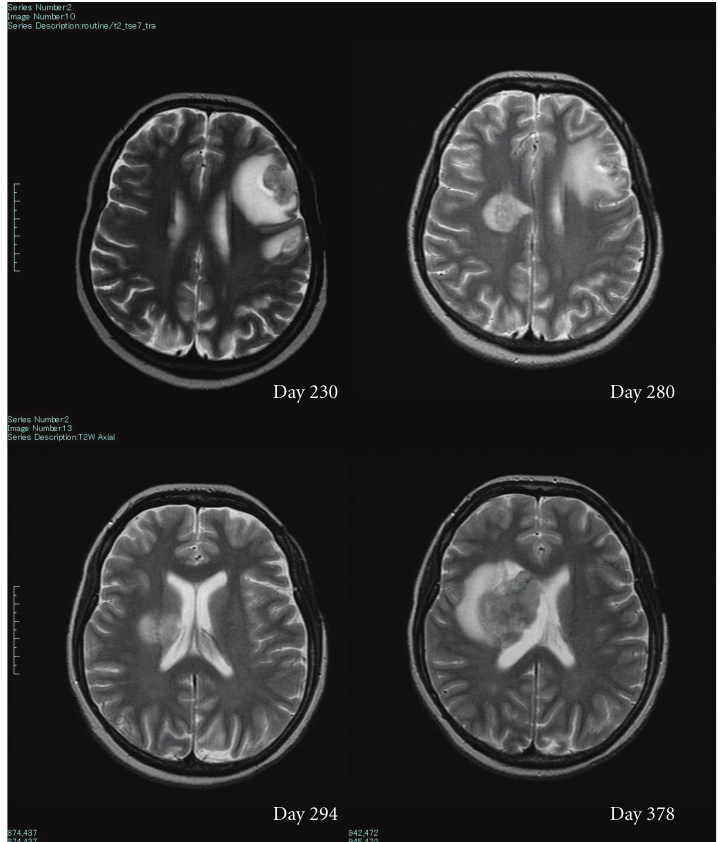
Figure 2: Brain MRI of the patient. Initial frontal tumor that was surrounded by T2 high edematous area disappeared completely on the 294th day, but right paraventricular tumor grew